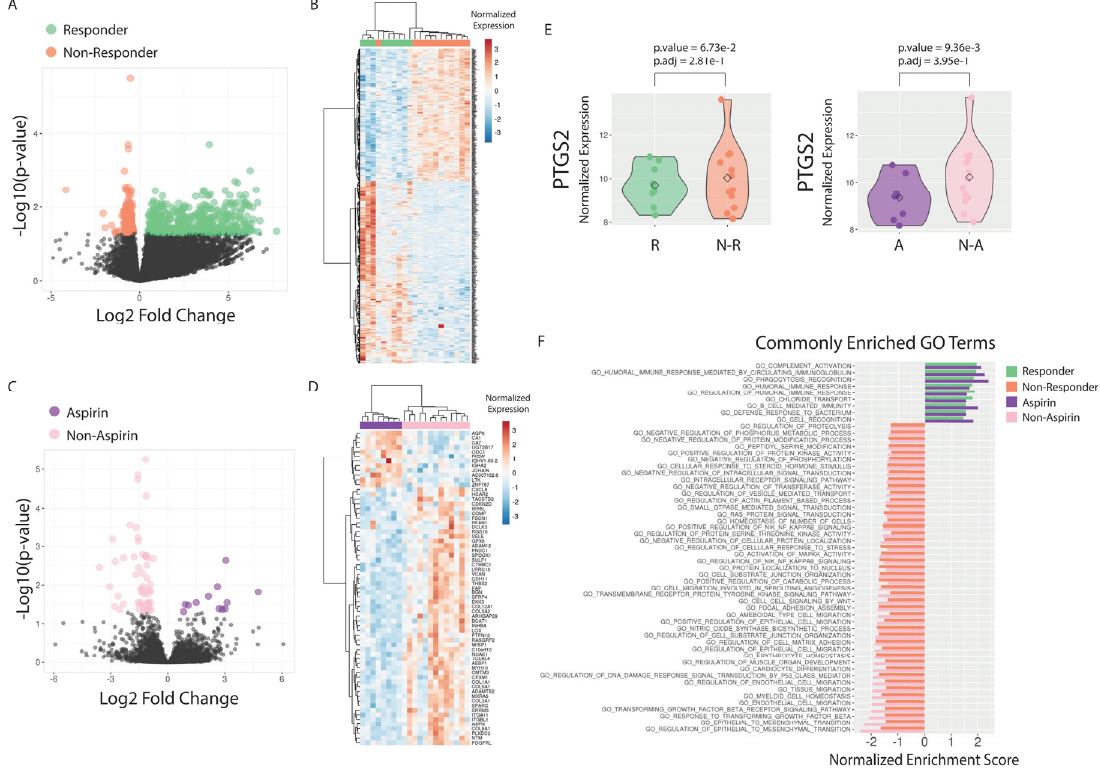
Figure 2. Differential expression determined by RNA-seq in chemoradiation therapy (CRT) responders ( n = 9) relative to non- responders ( n = 12) and aspirin users ( n = 8) relative to non-users ( n = 13). ( A ) Volcano plot depicting differential expression analysis between CRT responders and non-responders. Genes with significant difference between groups are highlighted (BH adjusted p -value < 0.05; responders = green, non-responders = orange). ( B ) Heatmap and supervised clustering of samples based on genes associated with CRT response. ( C ) Volcano plot depicting differential expression analysis between aspirin users and non-users. Genes with significant difference between groups are highlighted (BH adjusted p -value < 0.05; aspirin users = purple, non-users = pink). ( D ) Heatmap and supervised clustering of samples based on genes associated with aspirin use. ( E ) Normalized PTGS2 expression in patients associated with each comparison. ( F ) GO terms significantly associating with both CRT response and aspirin